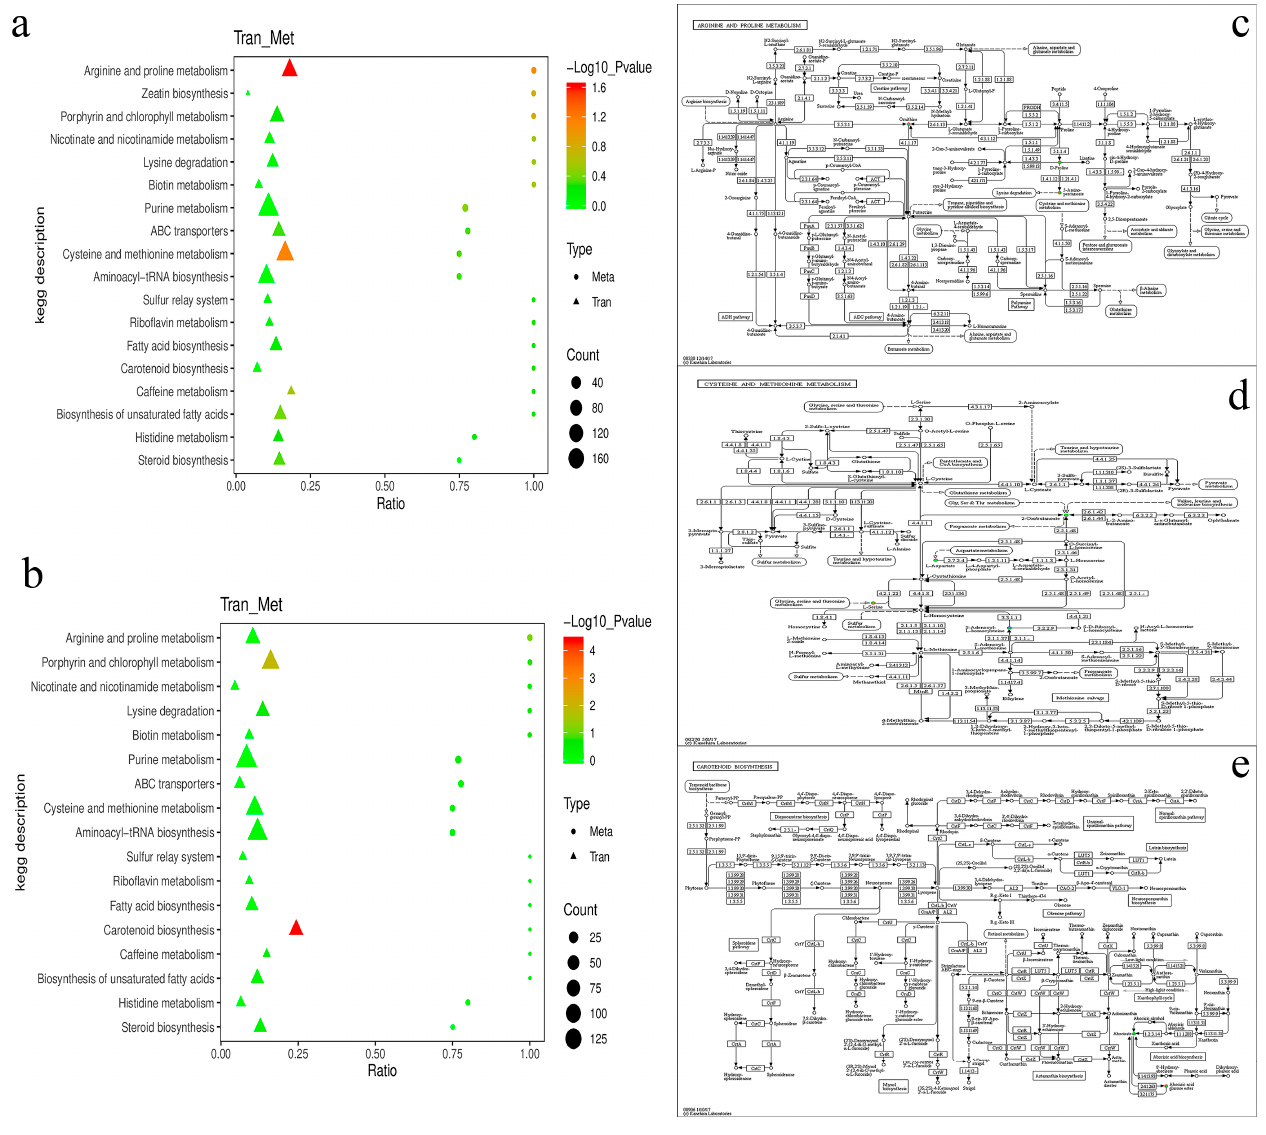
Figure 7. Joint analysis of the DEGs and DAMs in YH_4 vs. YH_3. ( a ) Scatter plot of differential genes and metabolites in positive polarity mode. ( b ) Scatter plot of differential genes and metabolites in negative polarity mode. ( c ) The DEGs and DAMs simultaneously mapped to arginine and proline metabolism (ko00330). ( d ) The DEGs and DAMs simultaneously mapped to the cysteine and methionine metabolism (ko00270). ( e ) The DEGs and DAMs simultaneously mapped to carotenoid biosynthesis (ko00906). Solid circles in green indicate the metabolites noted, red circles represent a significantly upregulated gene or metabolite, blue circles represent a significantly downregulated gene or metabolite, and solid circles in green represent a gene that is both upregulated and down- regulated.